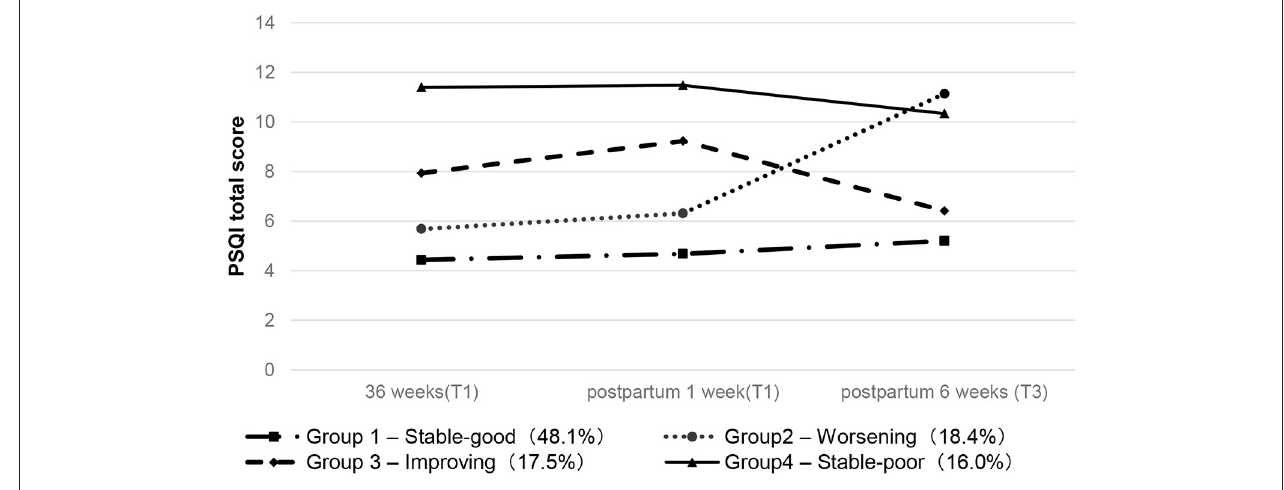
FIGURE 1 | Latent trajectories of four groups about sleep